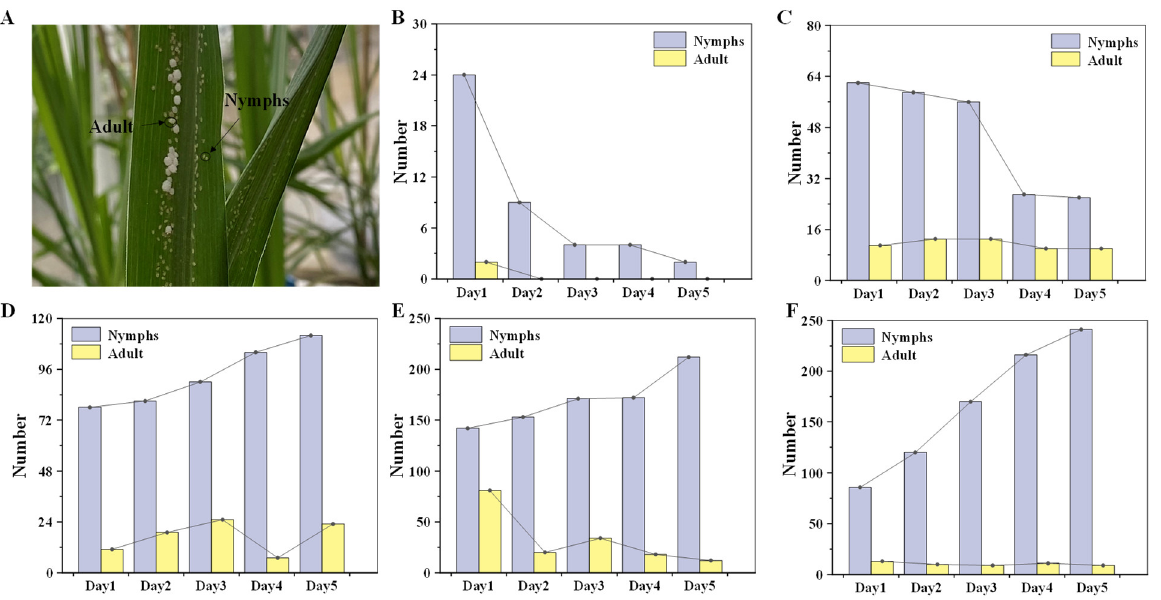
Figure 3. Aphid analysis. ( A ) Method of distinguishing between nymphs and adult aphids: the white individuals surrounded by honeydew were adults and the yellow individuals with less honeydew secretion were nymphs. Numbers of aphid nymphs and adults for five days after inoculation are shown in ( B ) PPA−16; ( C ) PPA−104; ( D ) 89; ( E ) 92; ( F ) 97.